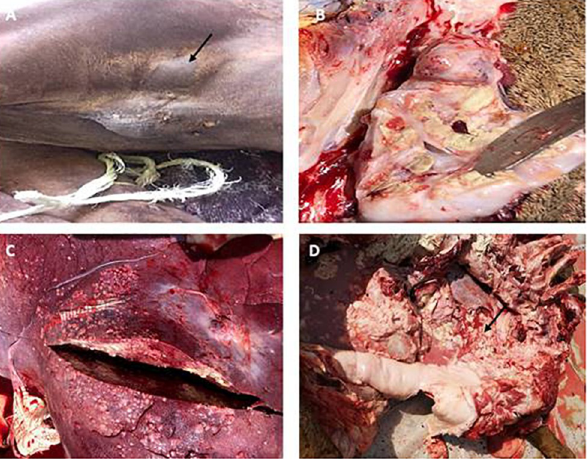
Fig 1. Gross lesions of CLA in dromedary camel. (A) superficial abscesses on the right prefemoral lymph nodes (iliaci externi) (arrow). (B) Incised right inferior cervical lymph node (cervicales laterals) showing multiple caseated caseous pyogranulomas containing yellowish-cheesy martials. (C) Liver showing multifocal-diffused pyogranulomas contained yellowish- cheesy pus. (D) Thoracic cavity showed multiple open large abscesses in the lung with adhesion to the chest wall